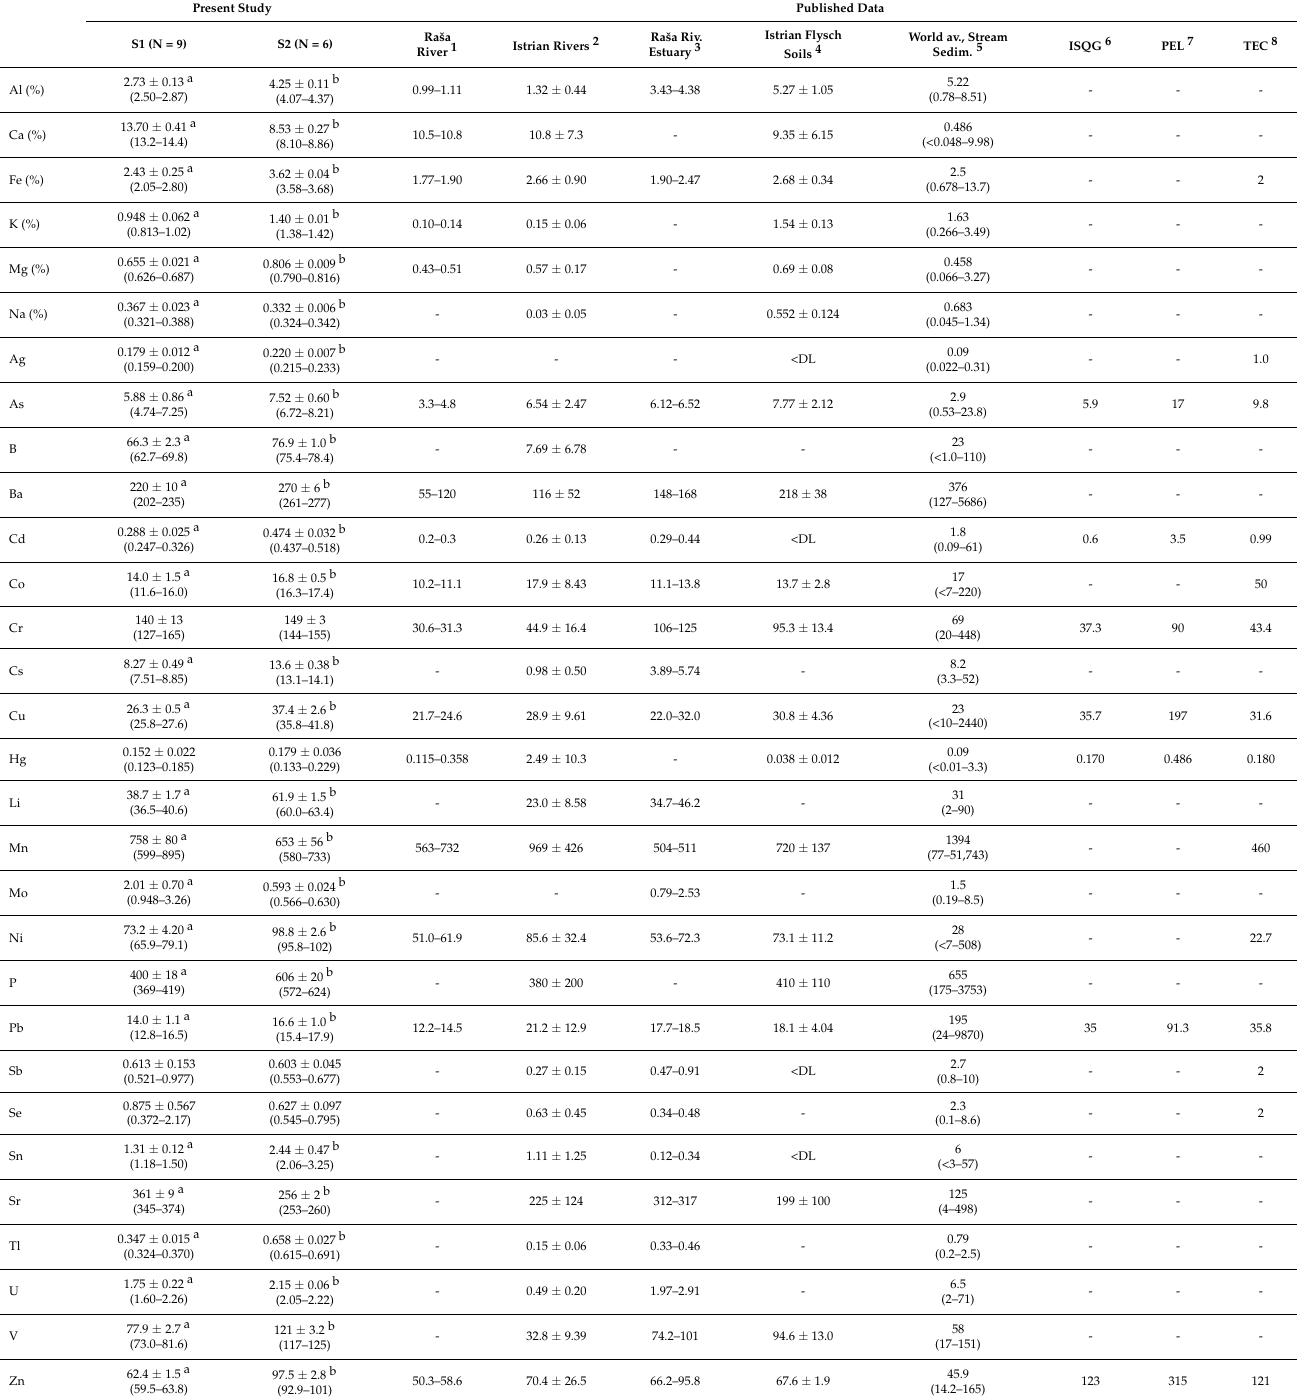
Table 3. Average concentrations (arithmetic mean ± SD [range]) of inorganic elements in sediments from the Raša River (in mg kg − 1 dry weight except when stated otherwise) compared with relevant published data ( 1–5 ) and sediment quality guidelines ( 6–8